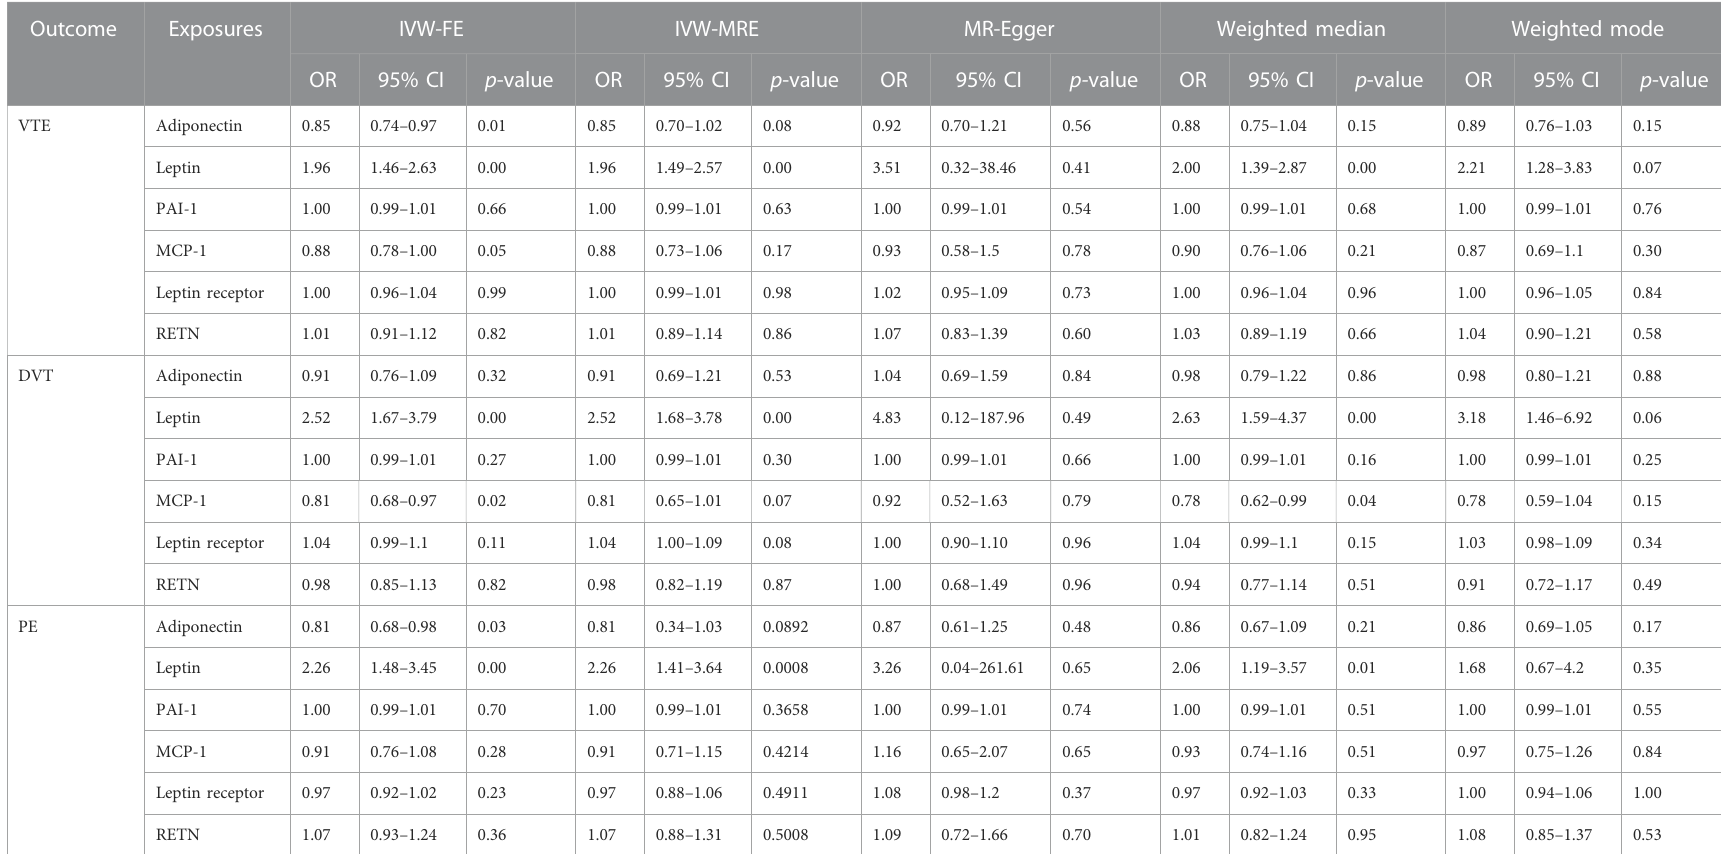
TABLE 3 Main result and sensitivity analysis of Mendelian randomization in circulating adipokine concentrations and VTE, DVT, and PE.